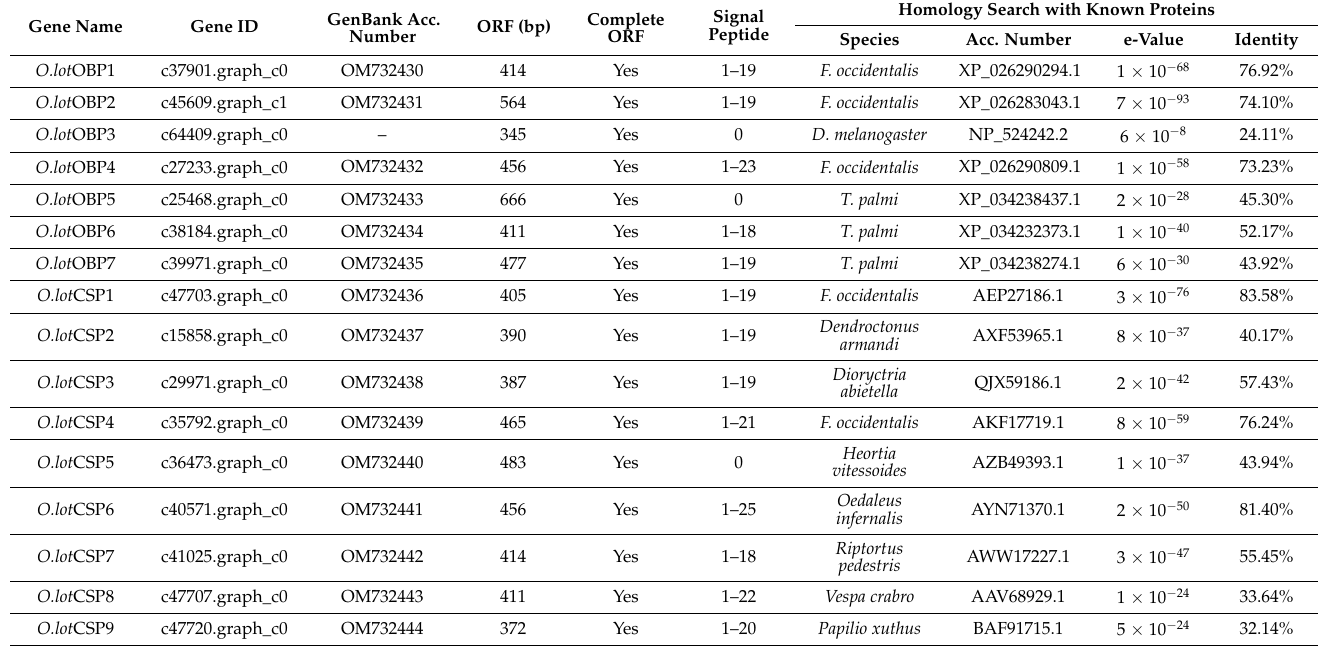
Table 2. Summary of odorant-binding proteins (OBPs) and chemosensory proteins (CSPs) sequences identified in female antennae of O. loti